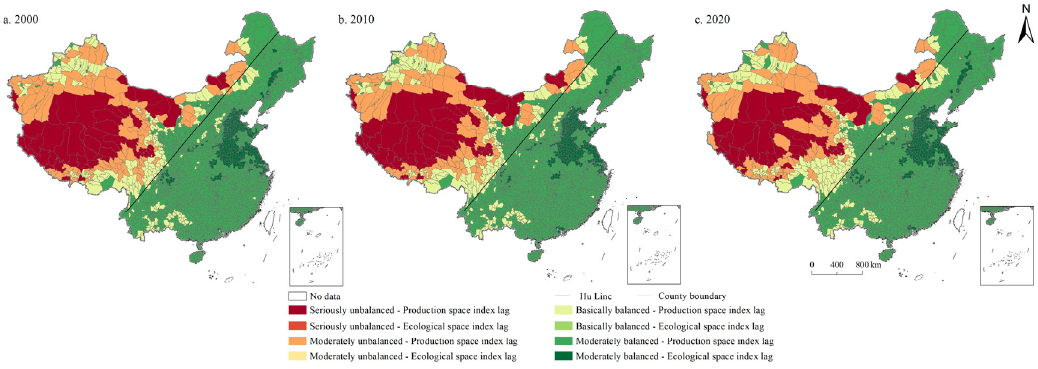
Figure 10. Spatial distribution of subcategories of coordination degree of PSI and LSI in China during